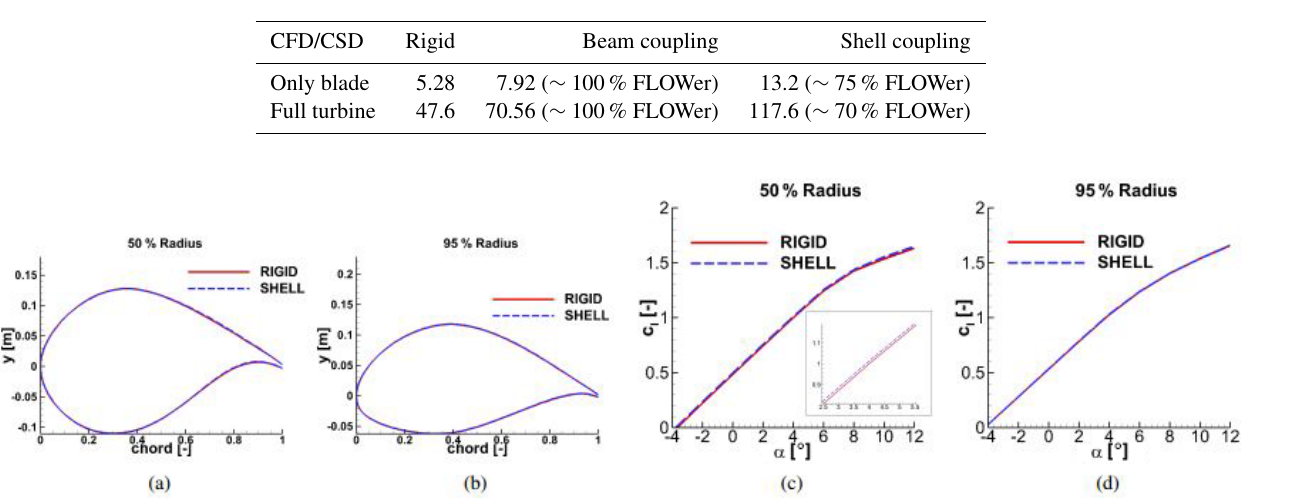
Table 6. Performance of the FSI coupling based on beam and shell elements in comparison to pure CFD calculations, in CPU per hour per time step (1 azimuthal degree) on average over one revolution.